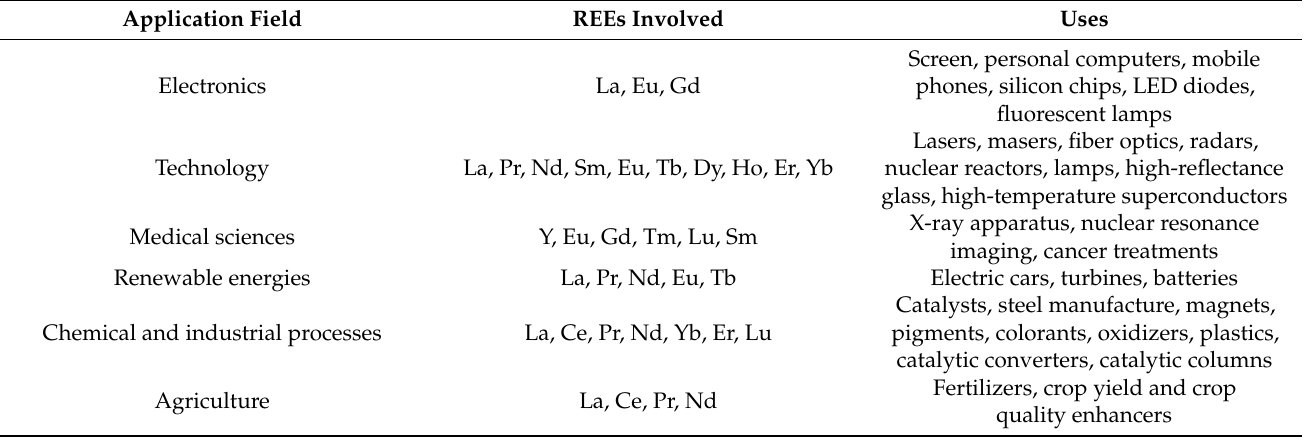
Table 1. Applications of